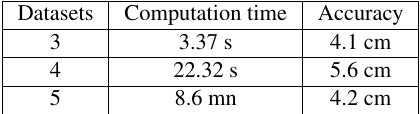
Table 4: ”cloud-to-cloud” method. Accuracy comparison be- tween photogrammetric and TLS model for the three datasets. Seven octree levels are used in this